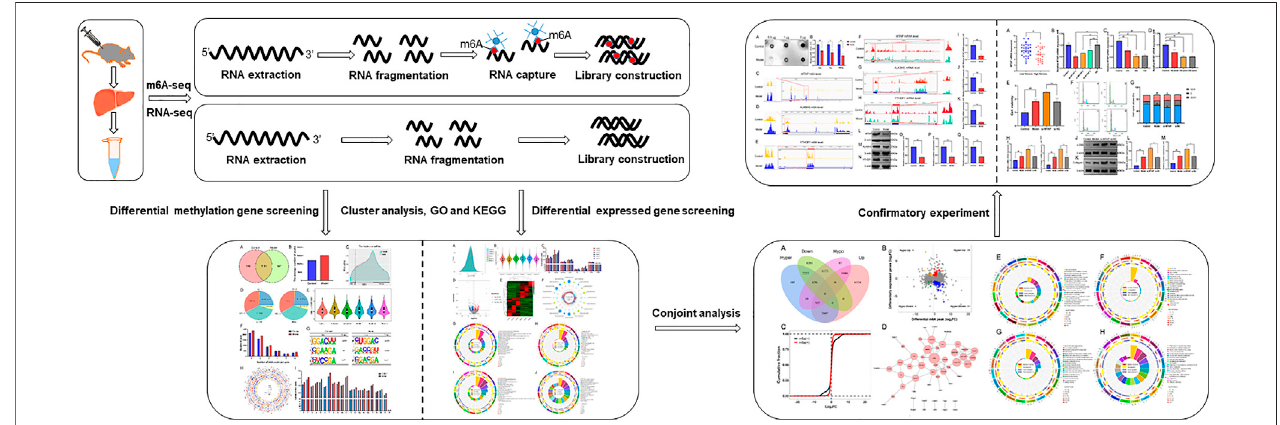
FIGURE 1 | A schematic diagram of m6A-seq and RNA-seq analyses of mice with LF. LF was induced by subcutaneous injection of CCl 4 in mice, and extracted total RNA from liver. Then, RNA was fragmented, and the m6A RNA was separated by immunoprecipitation magnetic beads speci fi cally recognizing m6A sites. Subsequently, the m6A-seq and RNA-seq library were constructed and sequenced.